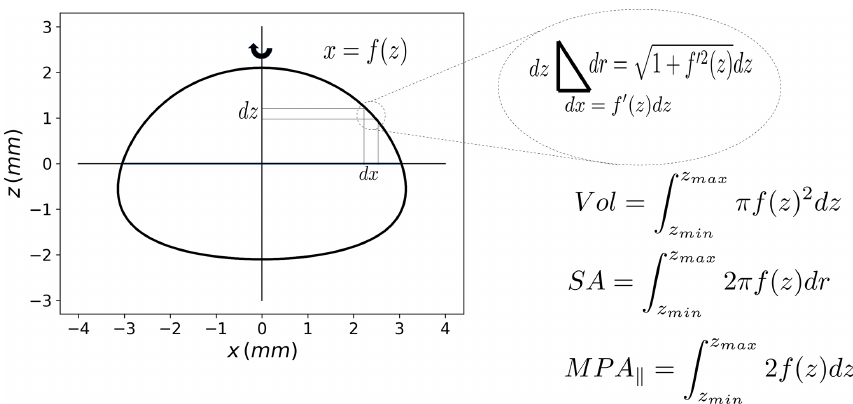
Figure 1. Illustration of how the volume (Vol), the surface area (SA) and the mean projected longitudinal cross-sectional area (MPA (cid:107) ) of the particle used in this paper can be computed via integral calculus. The drop is actually a solid of revolution around the “ z ” axis.